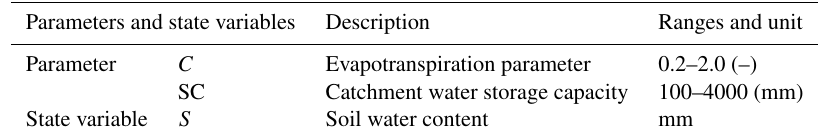
Table 1. States and parameters of the two-parameter monthly water balance